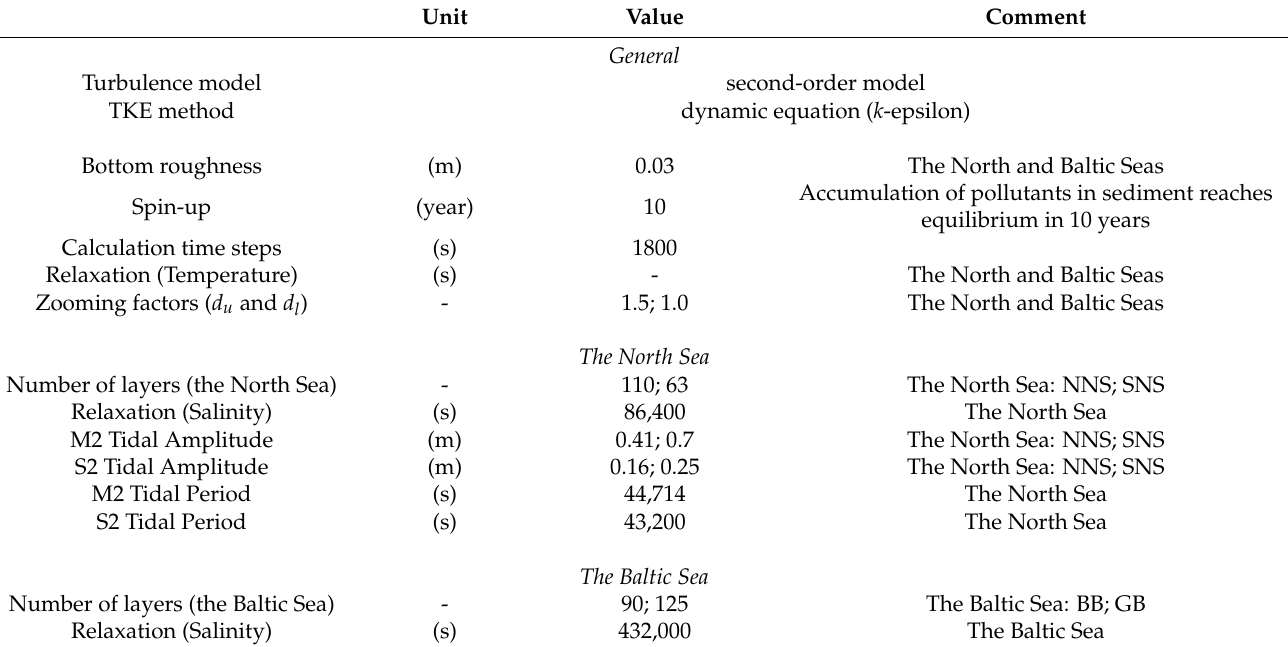
Table 1. GOTM Specification for current simulations (NNS—Northern North Sea, SNS—Southern North Sea; GB—Gotland Basin; BB—Bothnian Bay).